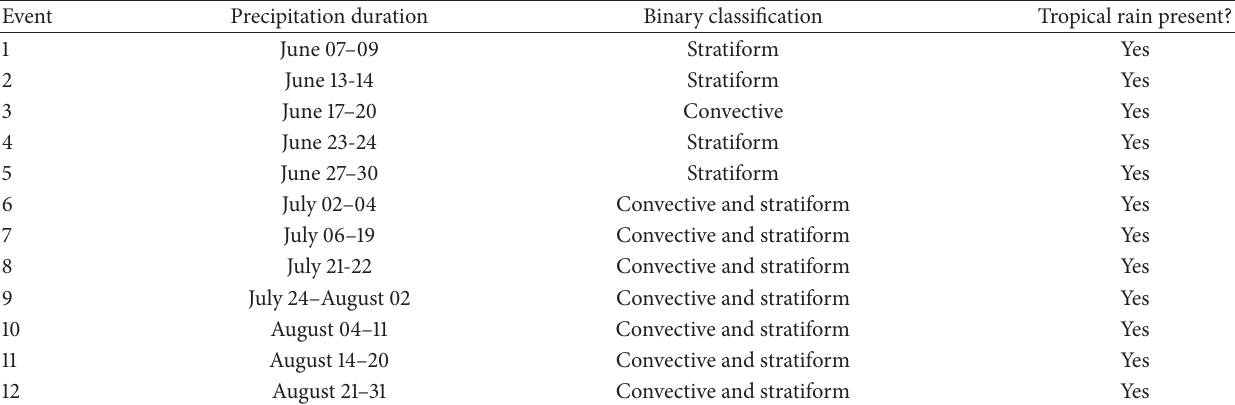
Table 4: Twelve precipitation events selected for performance